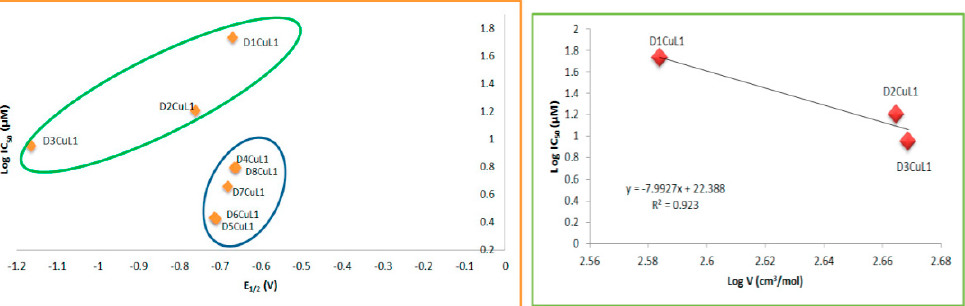
Figure 12. Relationship between molar volume or redox potential with antiproliferative activity of copper(II) coordination compounds with curcumin with CI 50 in SKLU-1.